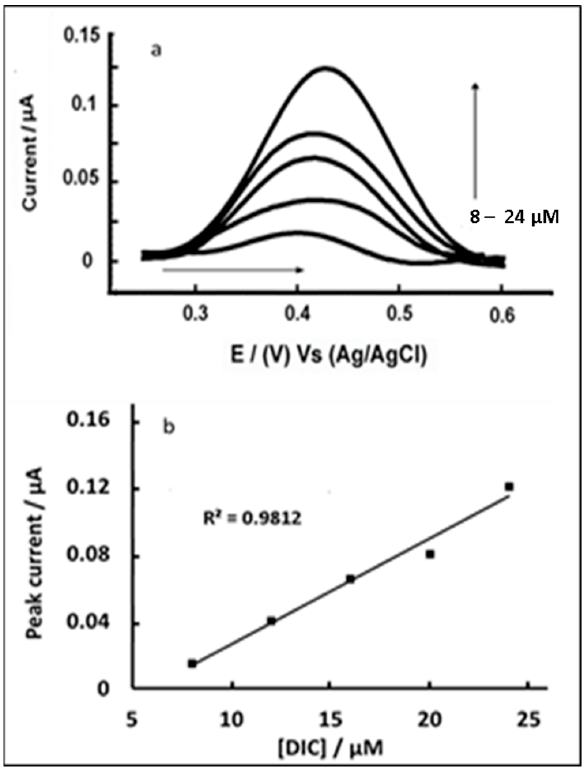
Figure 8. DPV (background subtracted) of increasing dibucaine concentrations (8,12, 16, 20 and 24 µM) in artificial serum (BSA presence) at the microinterface array ( a ) Calibration curve of peak currents vs. concentrations ( b ). Table 3. Recovery of dibucaine in serum (BSA presence).